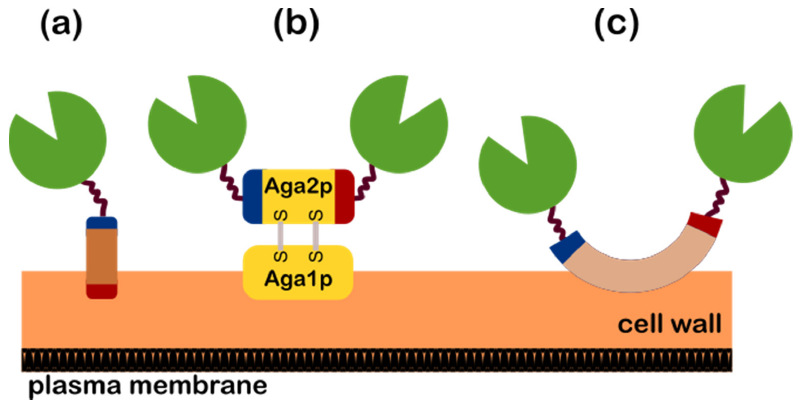
Figure 2. Common anchor protein systems used in yeast surface display: ( a ) N ‐ terminal fused anchor proteins (SAG1, SED1, or CWP2); ( b ) the a ‐ agglutinin display system; and, ( c ) the Flo1p ‐ based display system. Anchor proteins: N ‐ Terminal depicted in blue, and C ‐ terminal depicted in red.